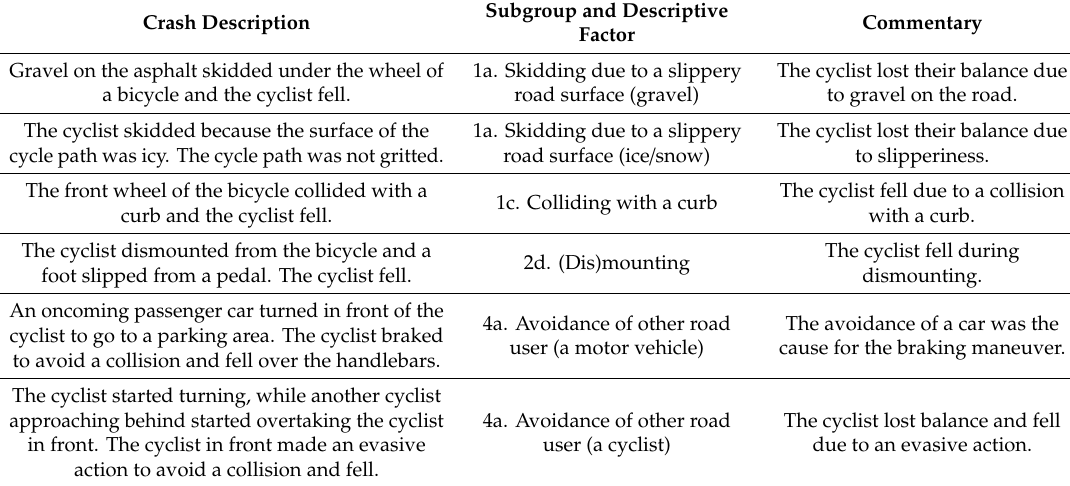
Table 1. Examples of the categorization of crashes into di ff erent subgroups and descriptive